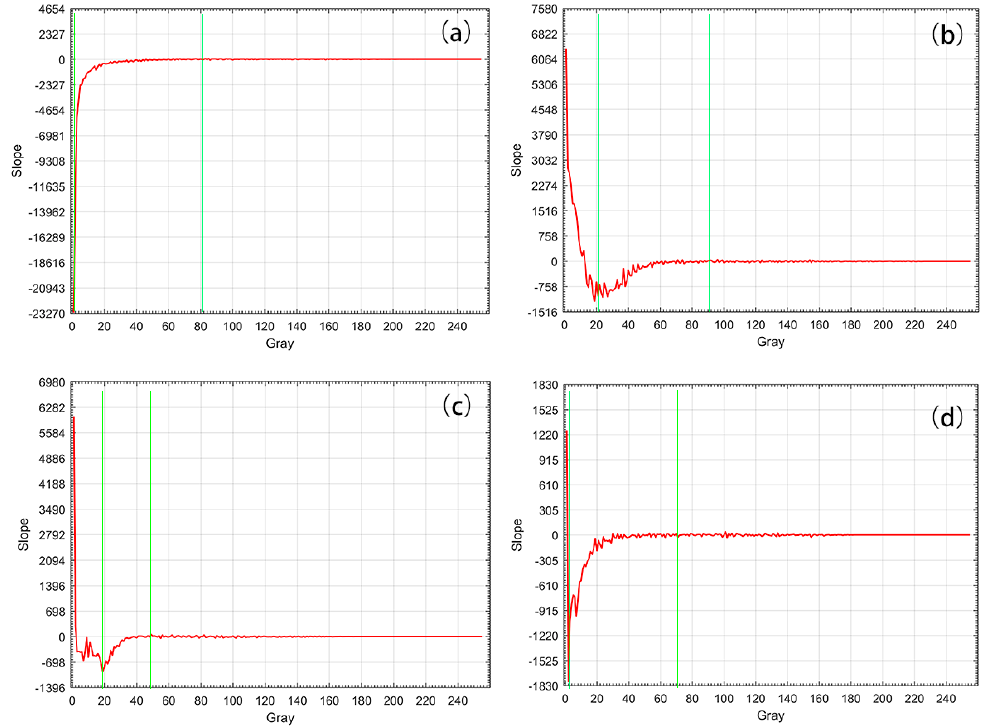
Figure 16. TRP using the proposed framework for each experiment; the predicted ranges are: ( a ) [0,84]; ( b ) [26,91]; ( c ) [18,48]; and ( d ) [0,72] for each experiment.